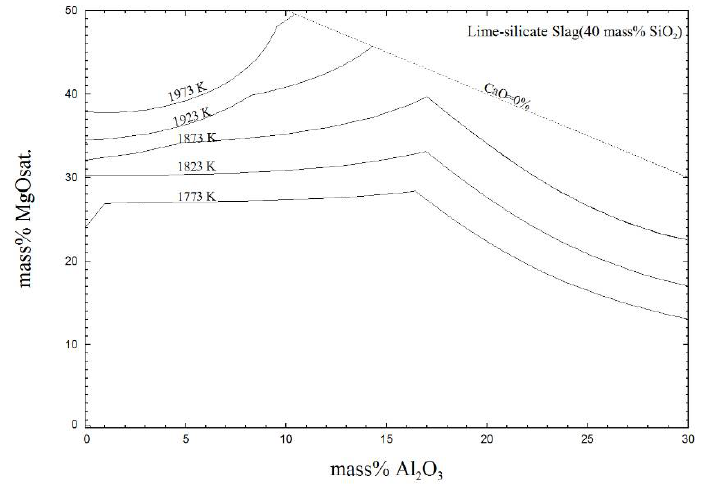
Figure 12. Effect of the Al 2 O 3 content on MgO solubility in slag with 40% SiO 2 at different tempera- tures.